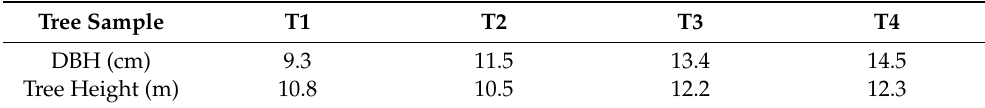
Table 2. Diameter at breast height (DBH) and tree height of target trees for dye injection experiment ( n =